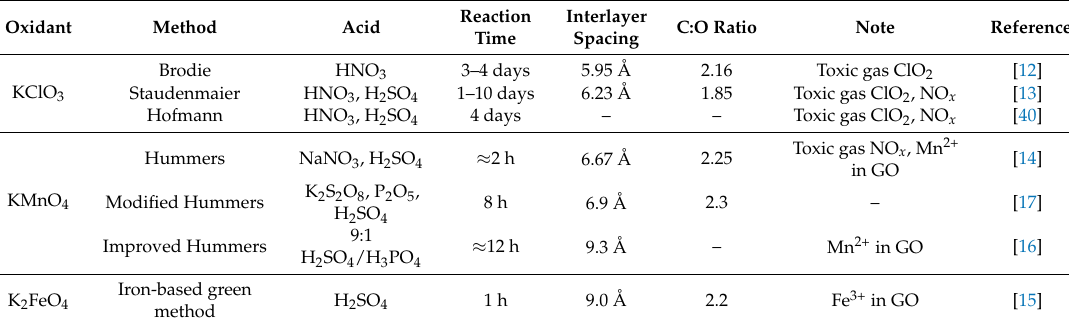
Table 1. Methods for the preparation of